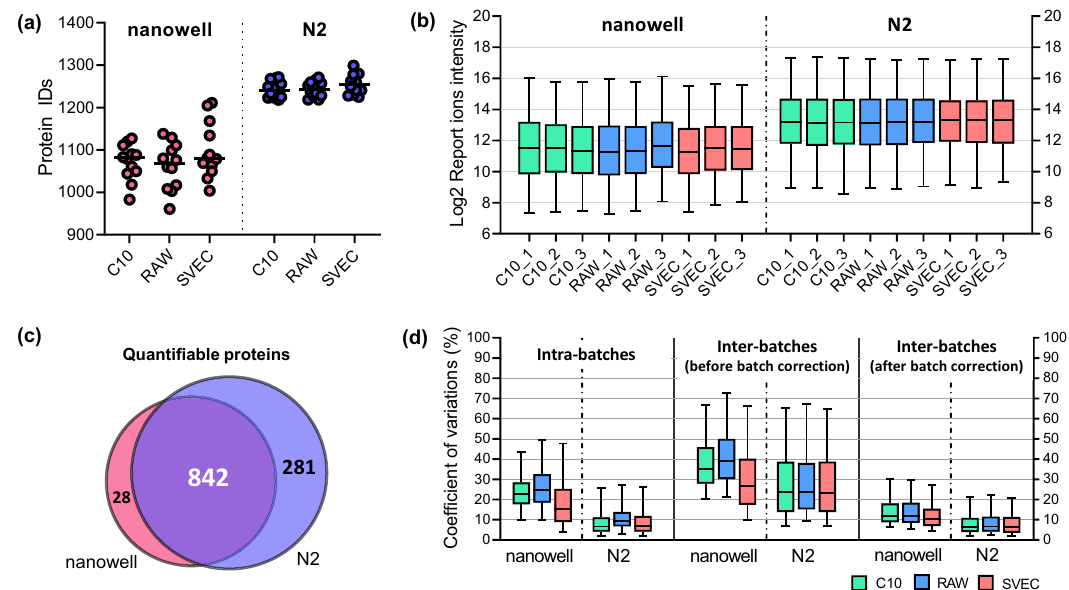
Fig. 2 Performance comparison between nanowell chip and N2 chip. a The numbers of protein identi fi cations from 0.1 ng tryptic peptides from three cell lines (four TMT sets from nanowell chip and four TMT sets from N2 chip). b The distributions of log2 transformed protein intensities in each TMT channel ( n = 870 proteins). c Venn diagram of quanti fi able proteins between nanowell and N2 chips. ( d ) The distributions of the coef fi cient of variations (CVs) for proteins identi fi ed in each cell type. Protein CVs were calculated inside single TMT batches (left), among different TMT batches without batch corrections (middle), and with batch correction (right). From left to right, the number of proteins ( n ) are: 1005, 1002, 975, 1213, 1233, 1221, 745, 747, 759, 938, 927, 944, 736, 738, 747, 937, 924, and 940, respectively. In b and d , center lines show the medians; box limits indicate the 25th and 75th percentiles; whiskers extend 1.5 times the interquartile range from the 25th and 75th percentiles. Source data are